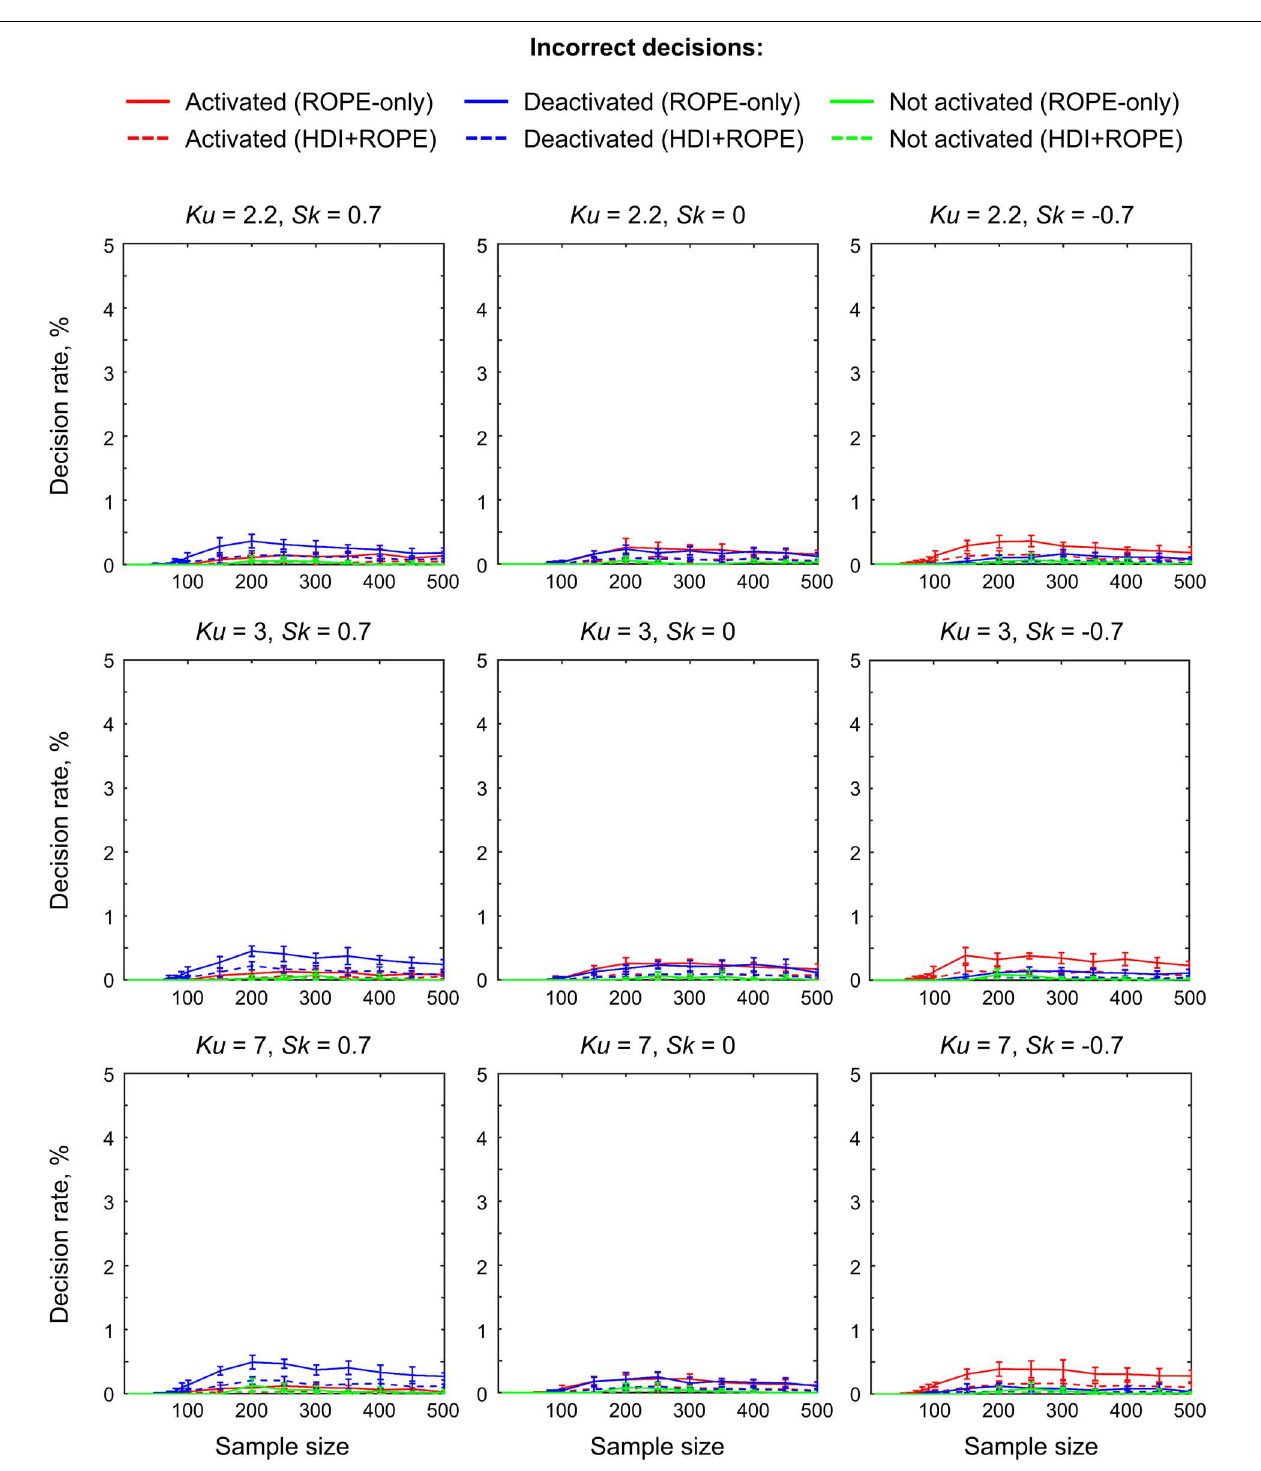
FIGURE 17 | Simulations results for the dependencies of the incorrect decision rate on the sample size. Data were drawn from normal ( Ku = 3, Sk = 0) and non-normal distributions with weak effect and high noise ( θ = 0.1%, SD = 0.4%). BPI was implemented using γ = 1 prior SD θ . The error bars represent the mean and standard deviation across ten random